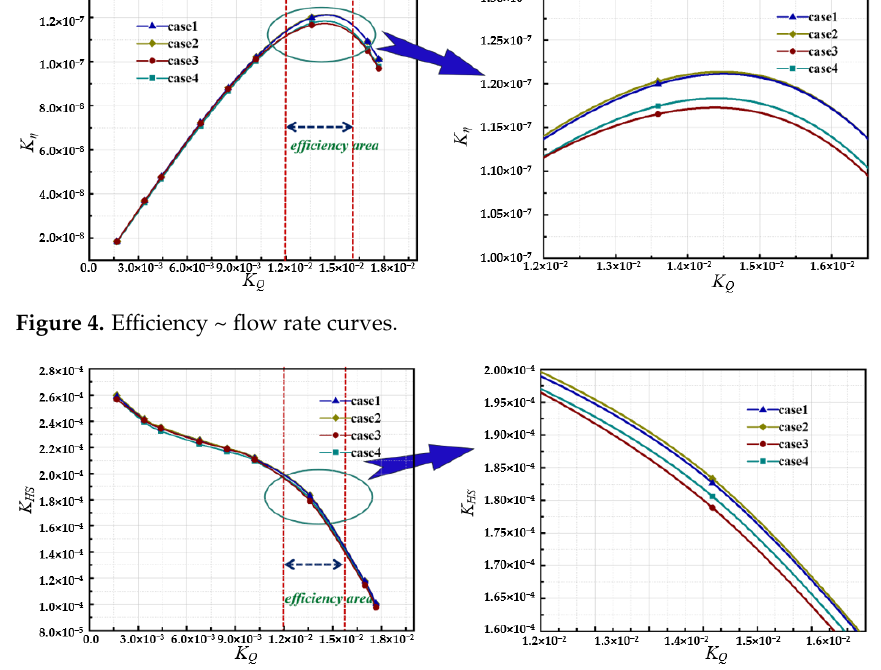
Figure 5. Head ~ flow rate curves.